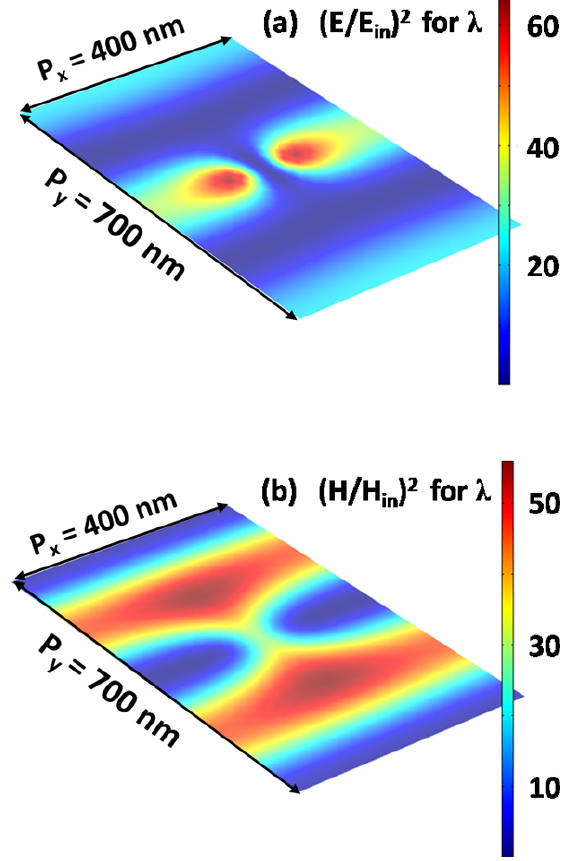
Figure 3. The intensity distributions of the electric fields ( a ) and the magnetic fields ( b ) on the surface of the graphene monolayer at the wavelength of λ = 1026.5 nm.